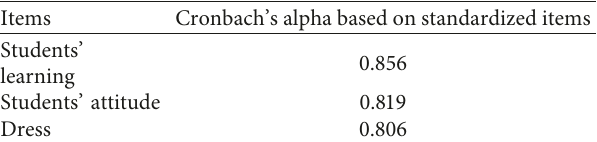
Table 1: Reliability